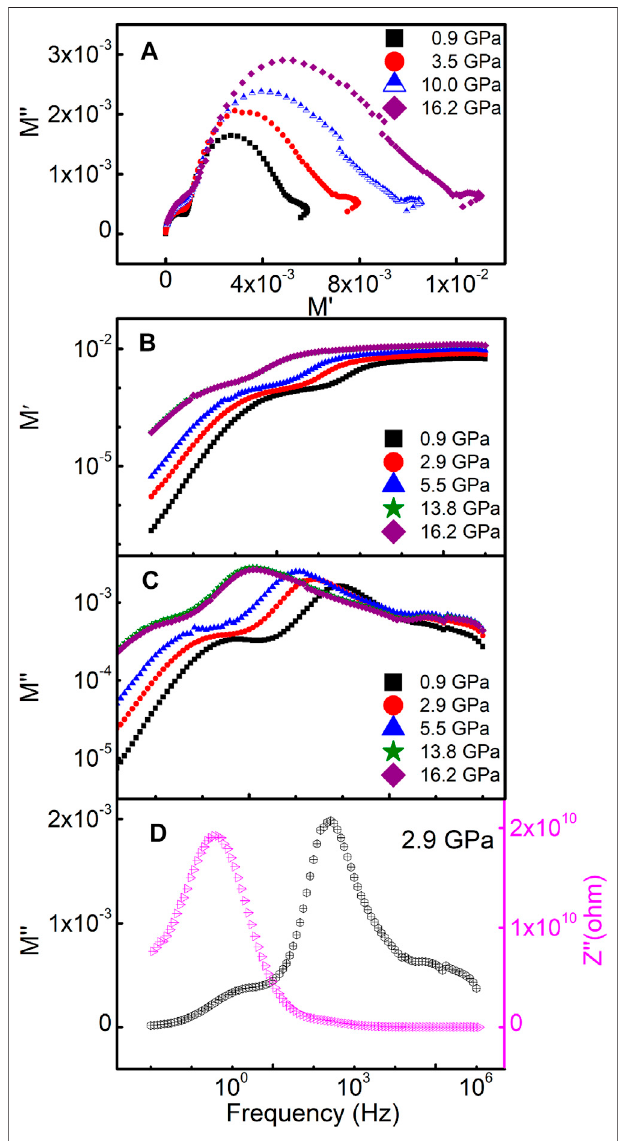
FIGURE7|(A) Complex modulus plots( M ″ ∼ M ′ ) at different pressures; (B, C) variations of M ′ and M ″ with frequency at different pressures; (D) frequency dependencies of M ″ and Z ″ in phenanthrene at 2.9